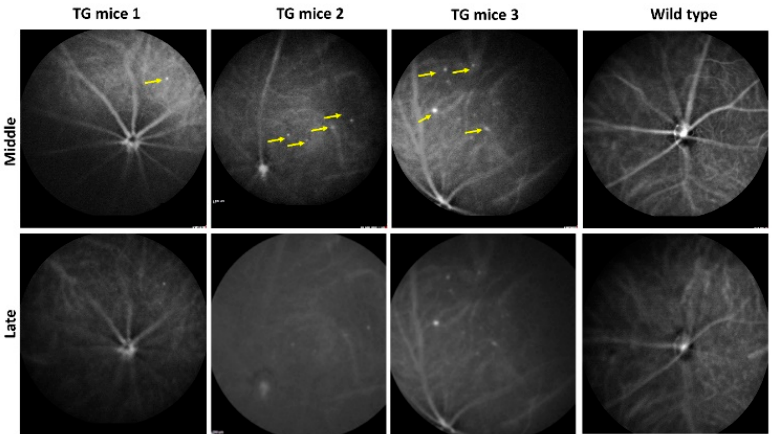
Figure 2. ICGA of CAG-HtrA1 and wild-type mice. Time course images shows middle to late phase ICGA features in the CAG-HtrA1 Tg mice and wild-type control. Punctate hyperfluorescent spots (yellow arrows) appears in the middle phase ICGA (can be observed in the Tg mice while no notable lesions in the wild-type mice. These lesions are considered as inner choroidal spots.